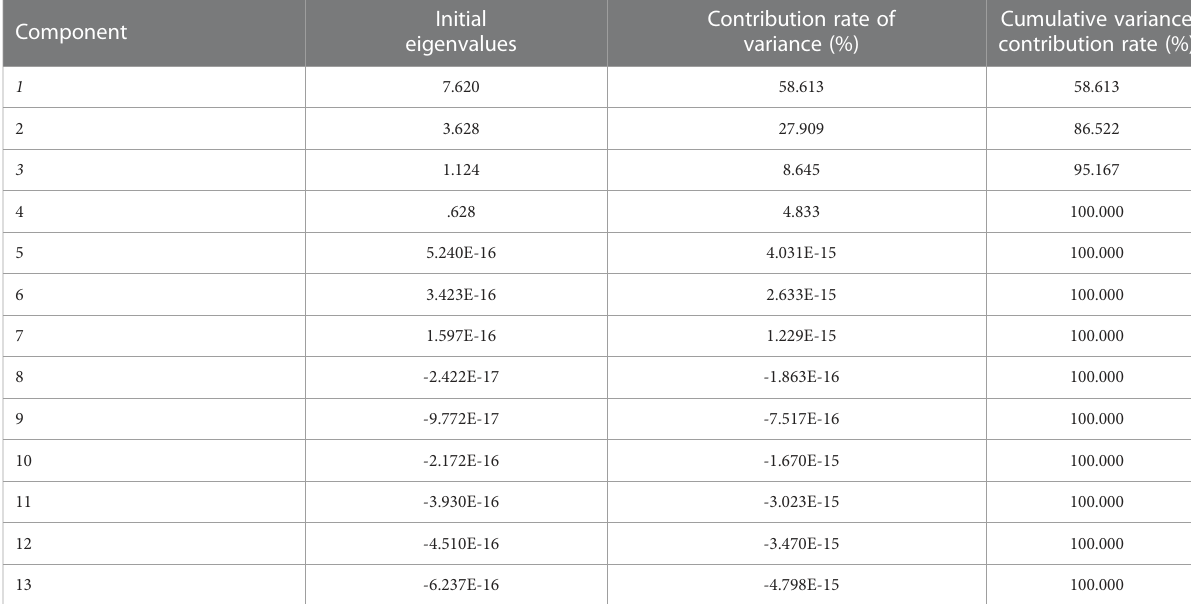
TABLE 2 Eigen values and contribution rates of principal components.